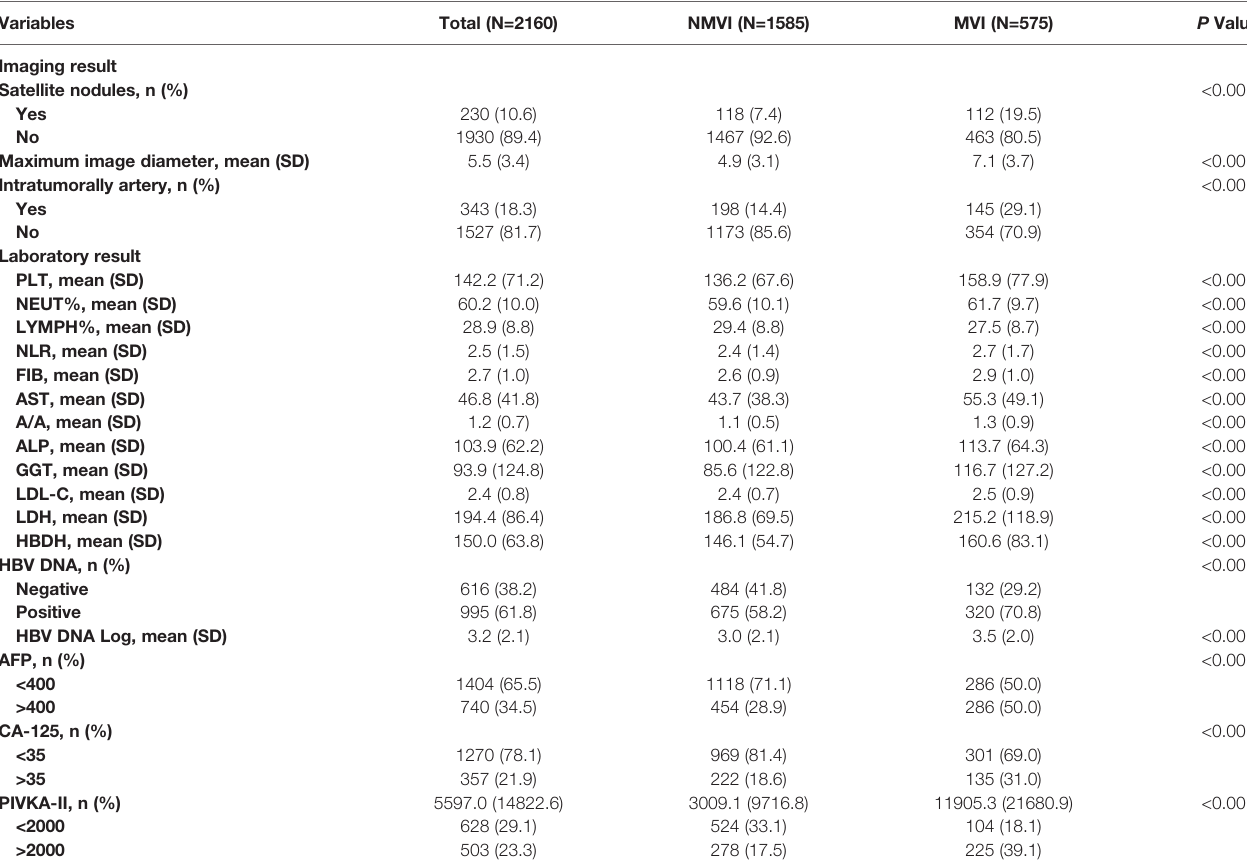
maximum image diameter, PIVKA-II level, AFP level, satellite